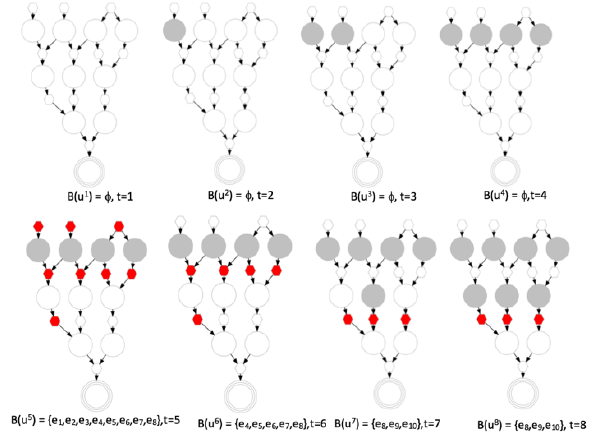
Figure 6. Sample evolution of deception policy when attacker is in real network. Security state is represented by shaded node and blocked exploits are